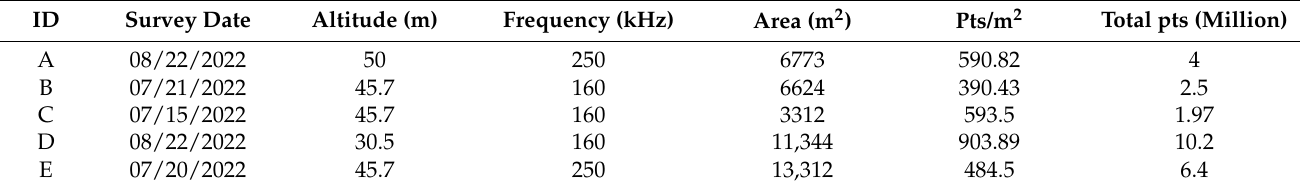
Table 2. Summary of collected Zenmuse L1 UAS ‐ LiDAR datasets for five sites.